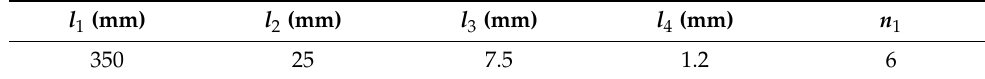
Table 1. Geometric data of the